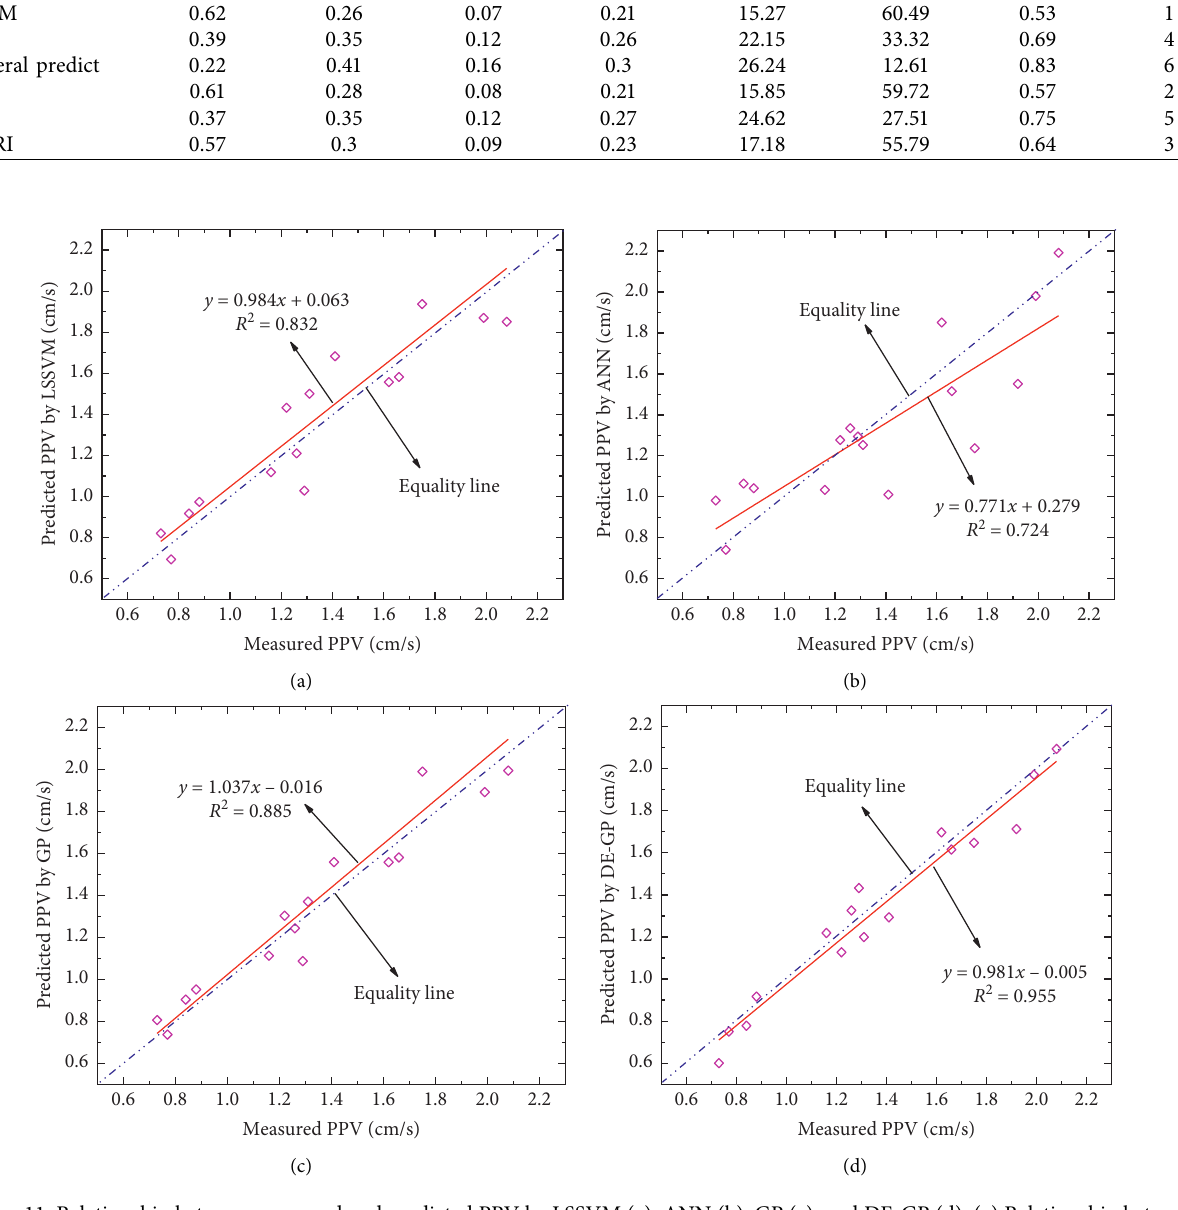
Figure 11: Relationship between measured and predicted PPV by LSSVM (a), ANN (b), GP (c), and DE-GP (d). (a) Relationship between measured and predicted PPV by LSSVM. (b) Relationship between measured and predicted PPV by ANN. (c) Relationship between measured and predicted PPV by GP. (d) Relationship between measured and predicted PPV by DE-GP.